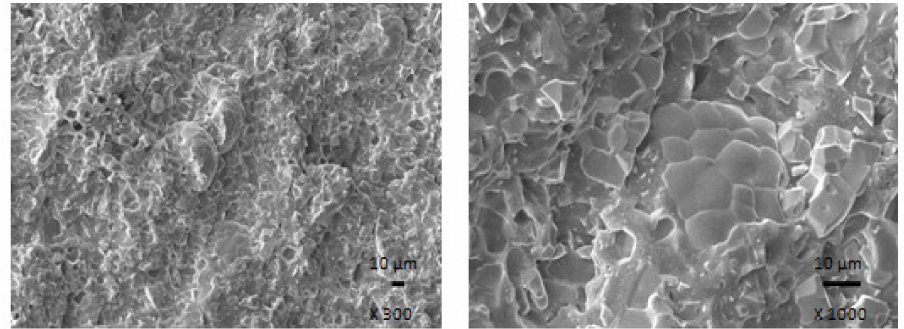
Figure 17. SEM images of hybrid CB/ferrite composite containing 300 phr of ferrite.